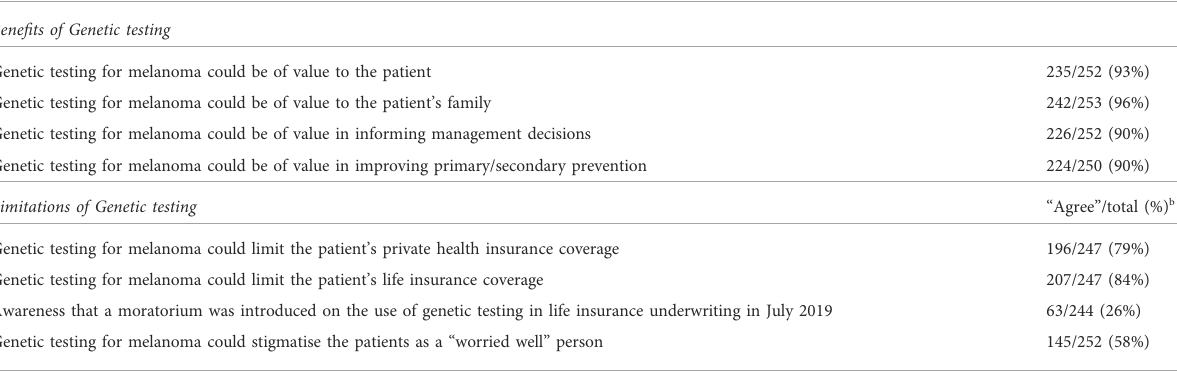
TABLE 3 Respondent ’ s perceptions on bene fi ts, and limitations of genetic testing in dermatology. Perceptions on genetic testing for melanoma in dermatology “ Yes ” /total (%) a